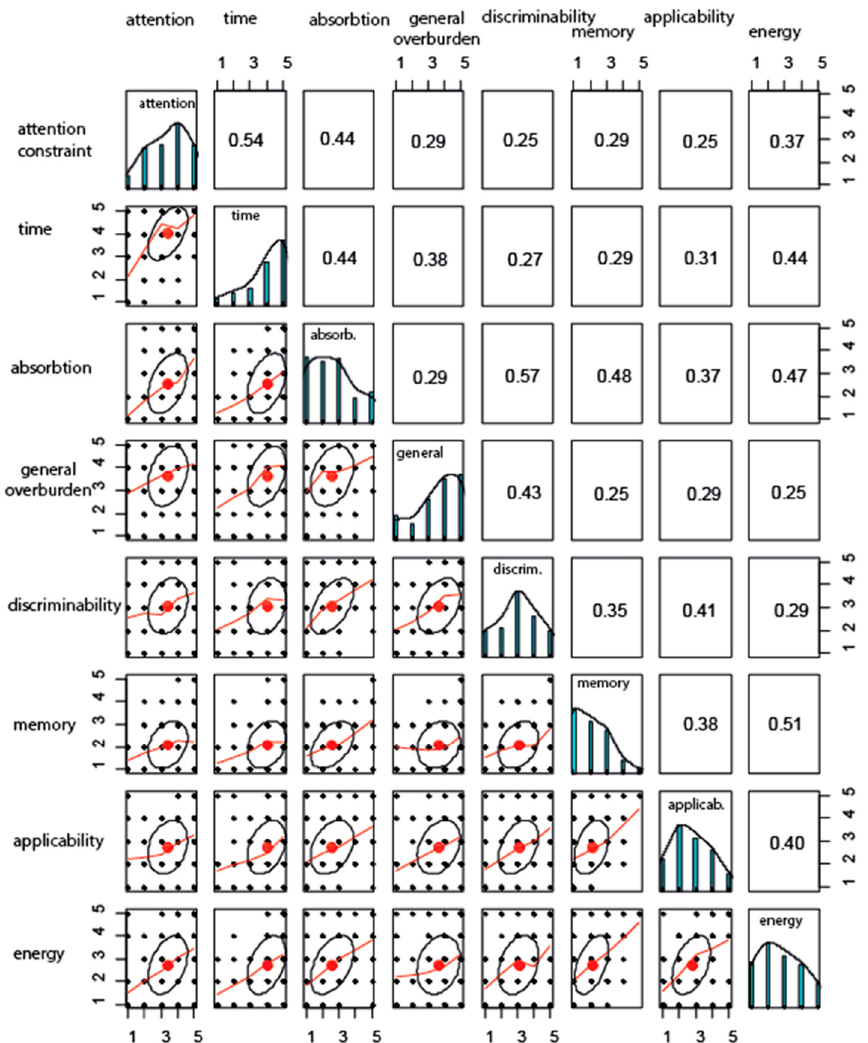
Figure 3. The correlational structure of